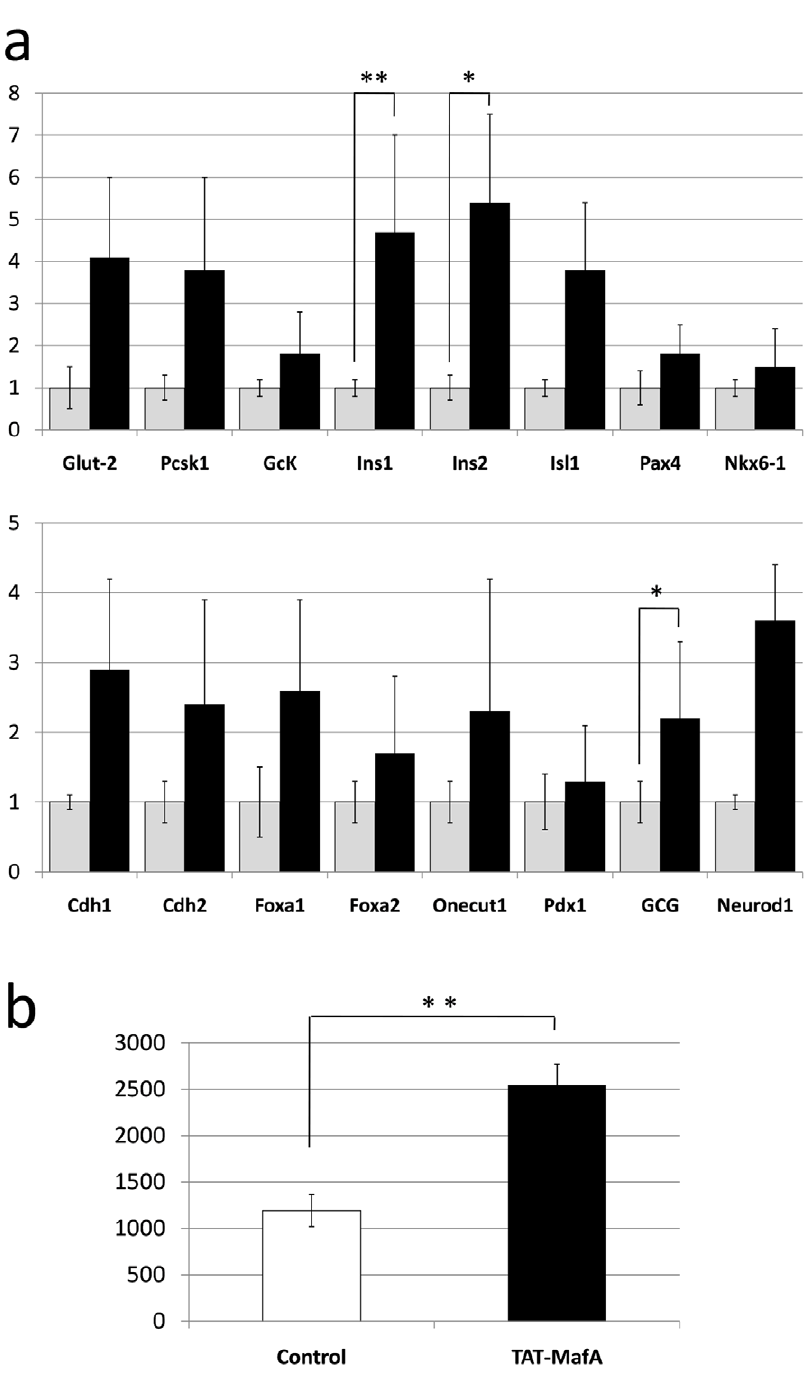
Figure 4. Gene and protein expression analysis of TAT-MafA-treated pancreata in neonate pups. (A) qRT-PCR of pancreatic markers in pancreata explanted from neonate pups. Grey columns: controls (embryos injected with vehicle). Black columns: TAT-MafA-treated embryos. Bars: standard error. Y axis: -fold increase over control (=1). (B) Total insulin extraction of pancreata explanted from neonate embryos injected in utero with vehicle (open column) or TAT-MafA (black column). Y axis: units of insulin